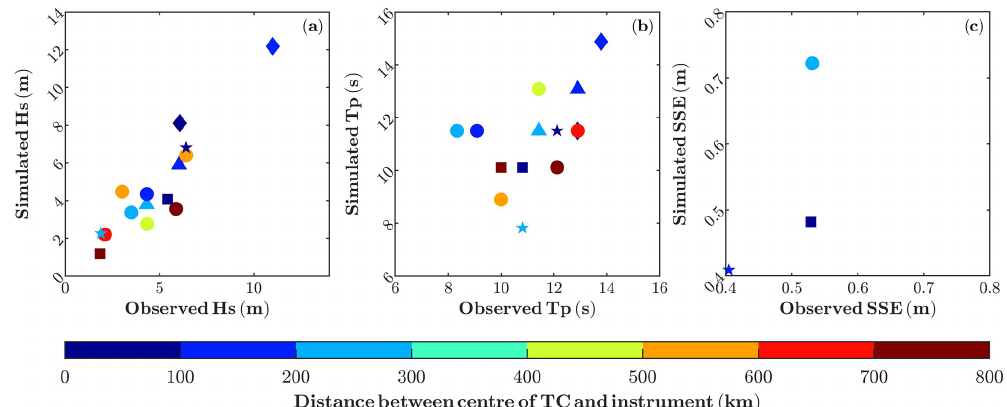
Figure 4. Comparison between modelled H s (a) , T p at the maximum of H s (b) and SSE (c) with the observations from in situ buoys (a, b) and tide gauges (c) . The forms indicate the TC (see Table 1), and the colours correspond to the distances between the eye of the TC and each instrument at the moment of the largest observed value (see Fig.